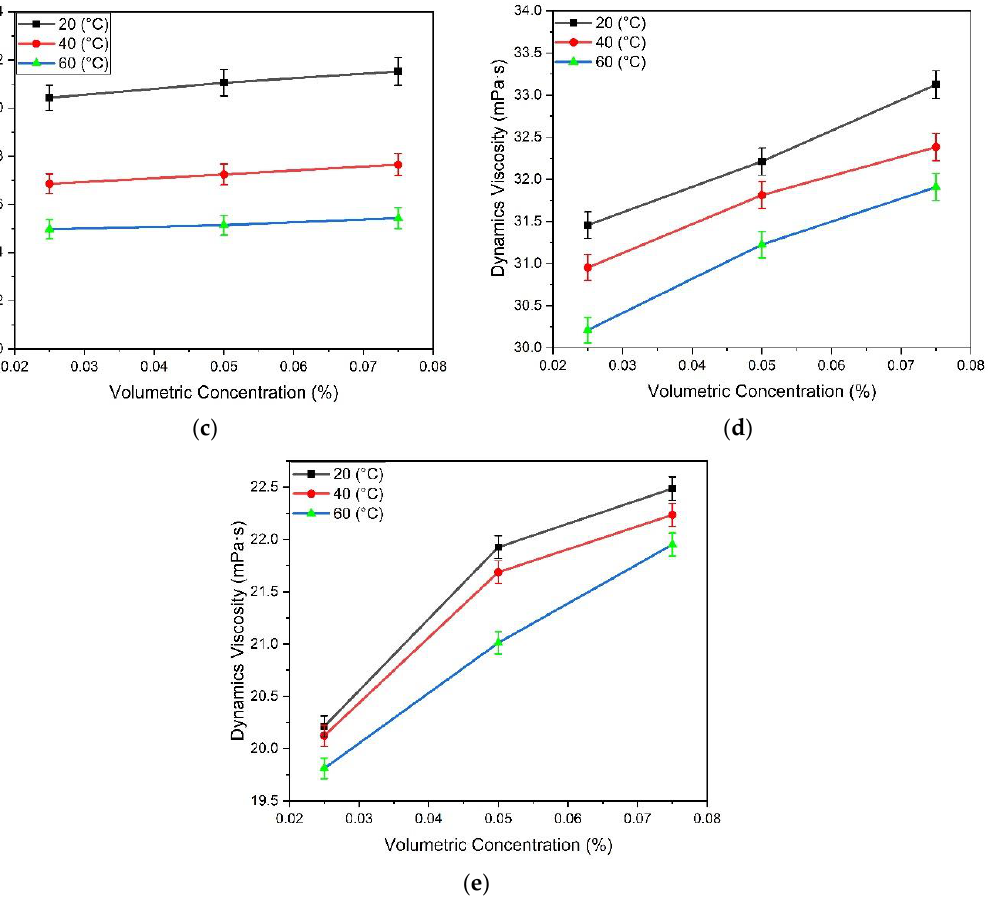
Figure 7. Variation in viscosity with temperature and volumetric concentrations at shear rate 200 s − 1 : ( a ) MWCNT – H 2 O, ( b ) MWCNT – EG, ( c ) Al 2 O 3 – H 2 O, ( d ) Al 2 O 3 -EG, ( e ) MgO – EG.